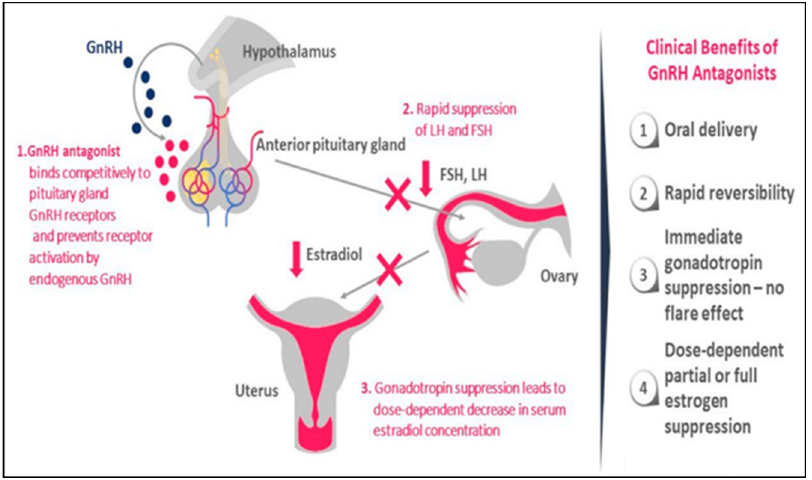
Figure 3. Mode of action and advantages of GnRH antagonist use in clinical practice (reprinted from